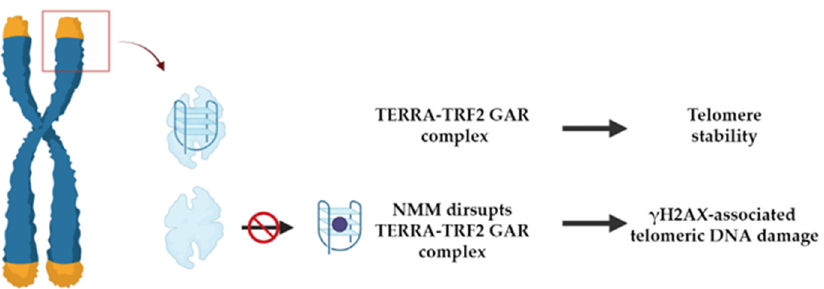
Figure 4. Schematic representation of TERRA rG4 interaction with TRF2 GAR domain that is required for telomere stability and integrity. Treatment of human melanoma cells with mesoporphyrin IX (NMM) leads to disruption of TERRA and the induction of γ H2AX-associated telomeric DNA damage.